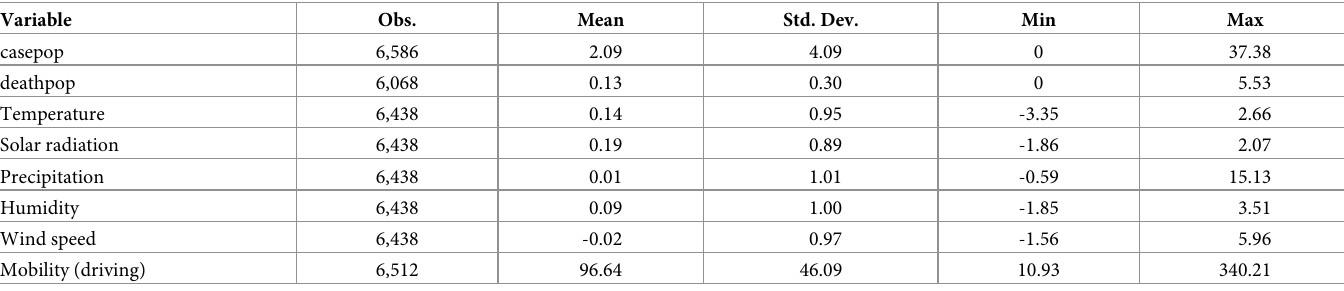
Table 3. Descriptive